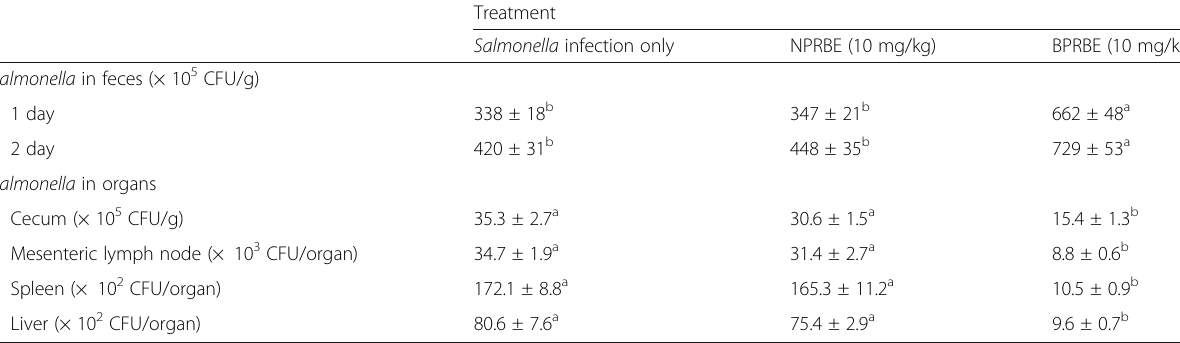
Table 3 Effect of NPRBE and BPRBE on bacterial load in feces and organs from Salmonella -infected mice Treatment Salmonella infection only NPRBE (10 mg/kg) BPRBE (10 mg/kg) Salmonella in feces (× 10 5